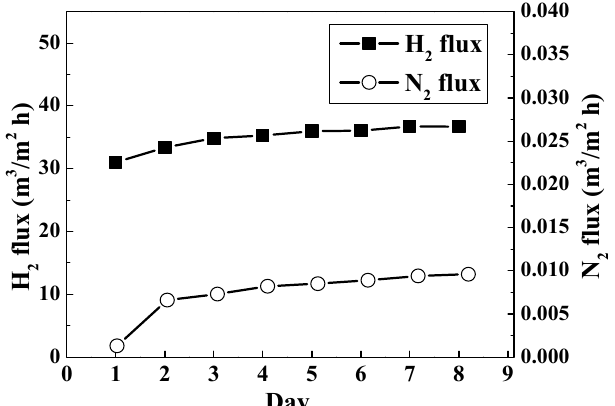
Figure 6. Thermal stability test of the Pd membrane prepared using the EDTA-free bath and the sequential addition of hydrazine.